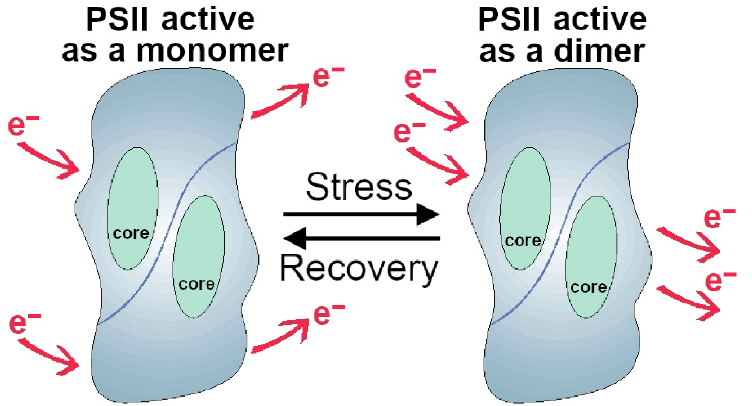
Figure 6. Hypothetical model of photosystem II (PSII) functional size interconversion from a monomer under normal conditions to a dimer under stress